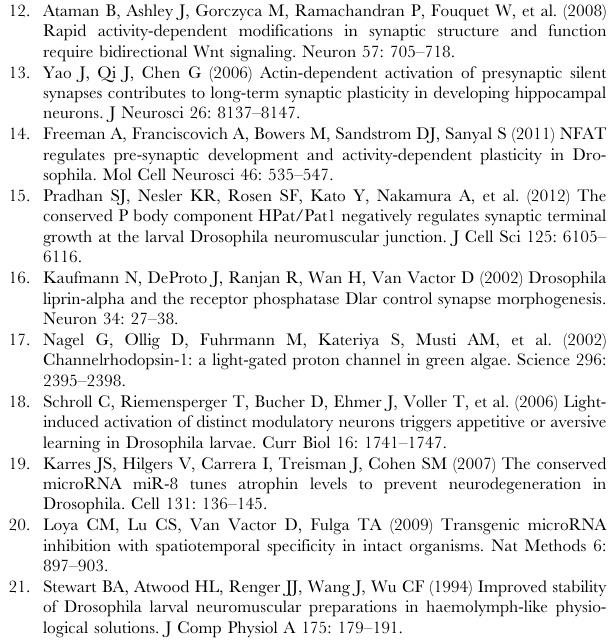
Table S1 Summary of raw miRNA microarray data. The relative change in expression levels on a miRBase 14.0 array for all detected miRNAs across treatment groups is indicated. N/A indicates a miRNA in the microarray that was not expressed at detectable levels. The full microarray data can be found in the Gene Expression Omnibus (GEO) of NCBI through accession number GSE43945. Table S2 Summary of raw miRNA RT-qPCR data. The relative change in expression levels for all miRNAs tested across